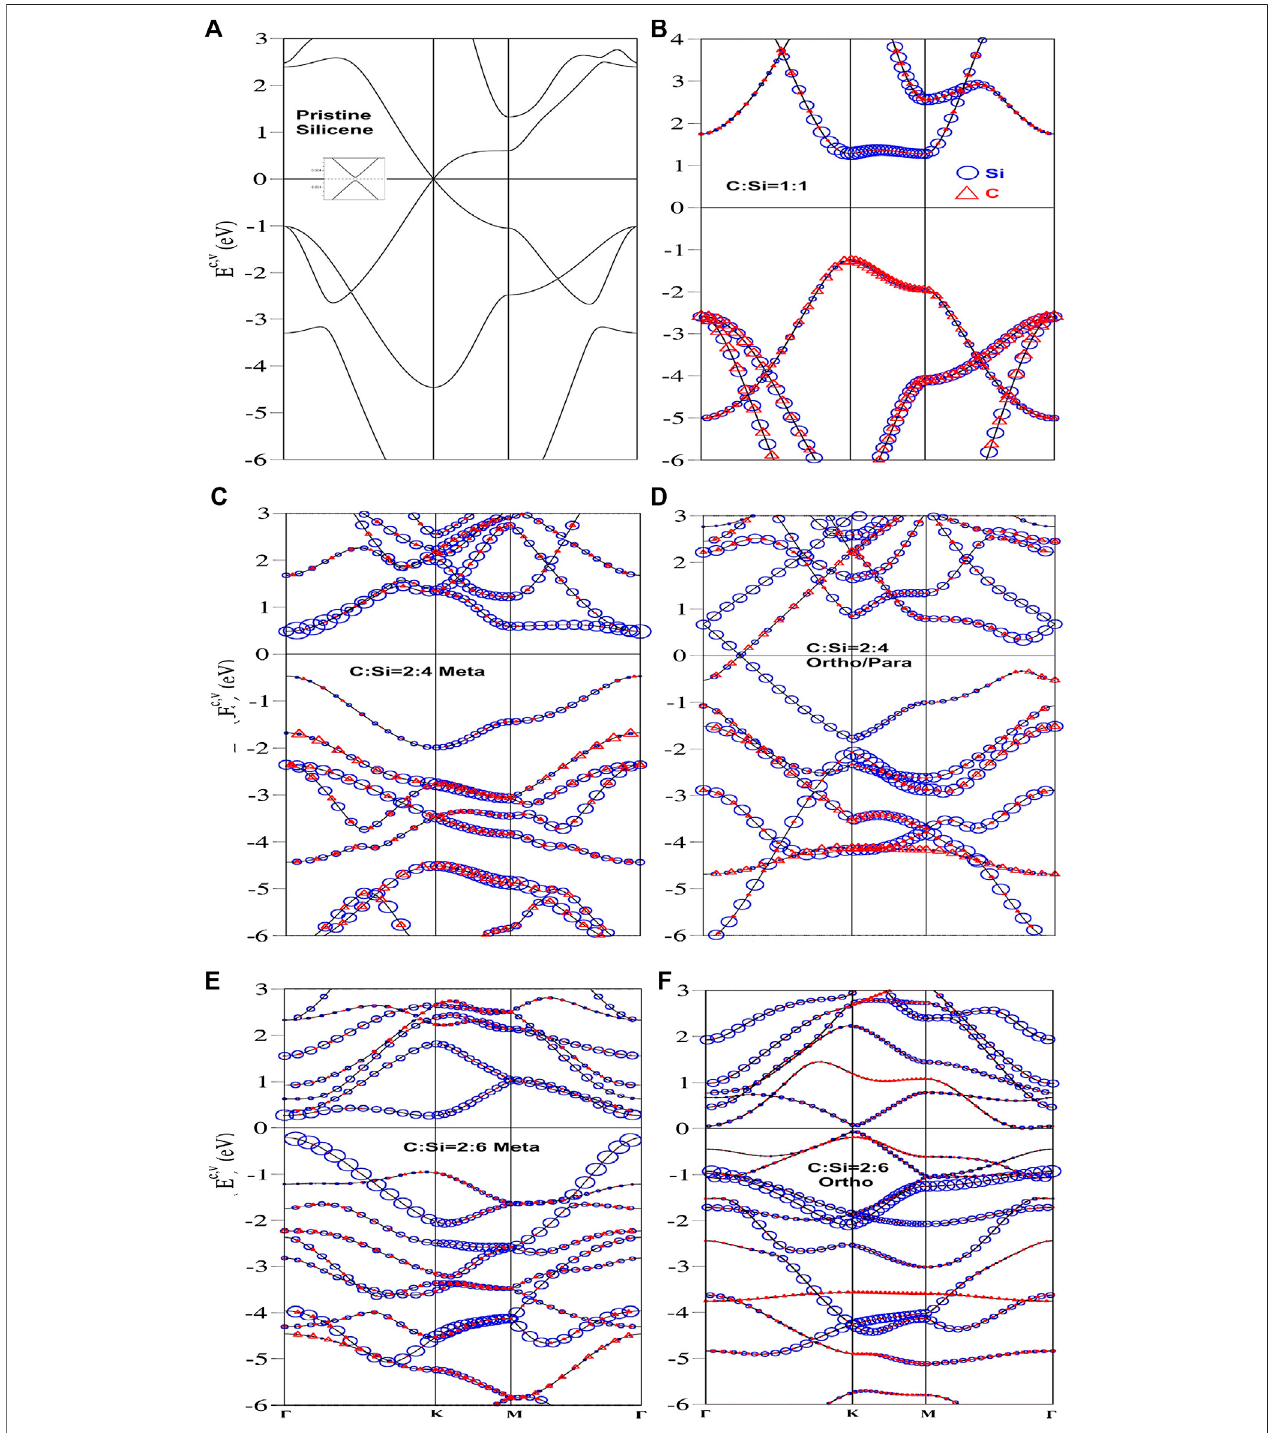
FIGURE3| Electronicstructures,withthedominanceofsiliconandcarbonatoms(thebluecirclesandredtriangleones),fortheC-substitutedsilicenesystems;the (A) pristine, (B) [1:1]-, (C) [2:4]-meta-, (D) [2:4]-ortho-/para-, (E) [2:6]-meta-, (F) [2;6]-ortho-, (G) [2:6]-para-, (H) [2:16]-meta-, (I) [2:16]-ortho-, (J) [2:16]-para-, (K) [1:7]- single-, (L) [1:17]-single substitution con fi gurations.